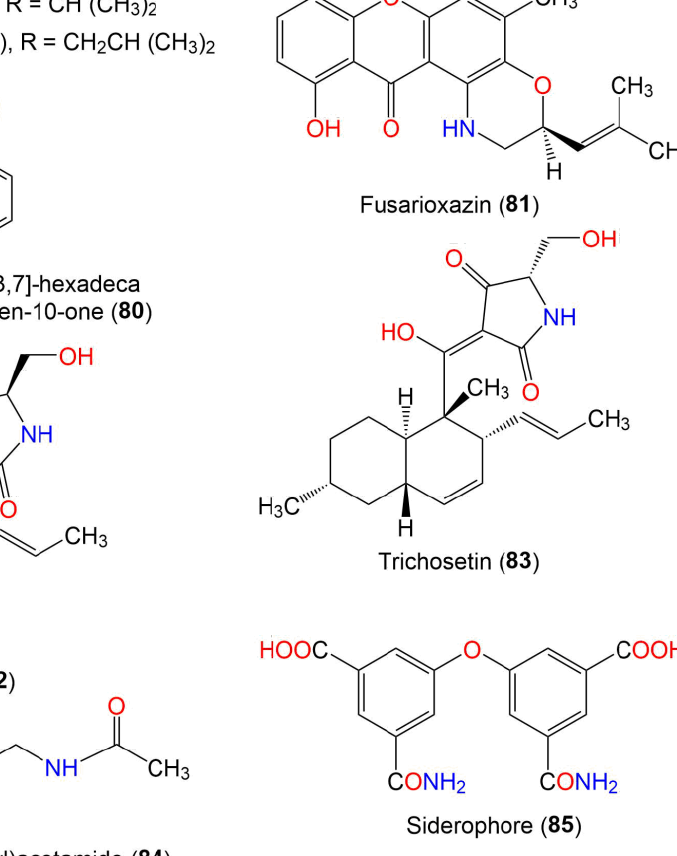
Figure 7. Structures of alkaloids ( 76 – 85 ) isolated from F. oxysporum .